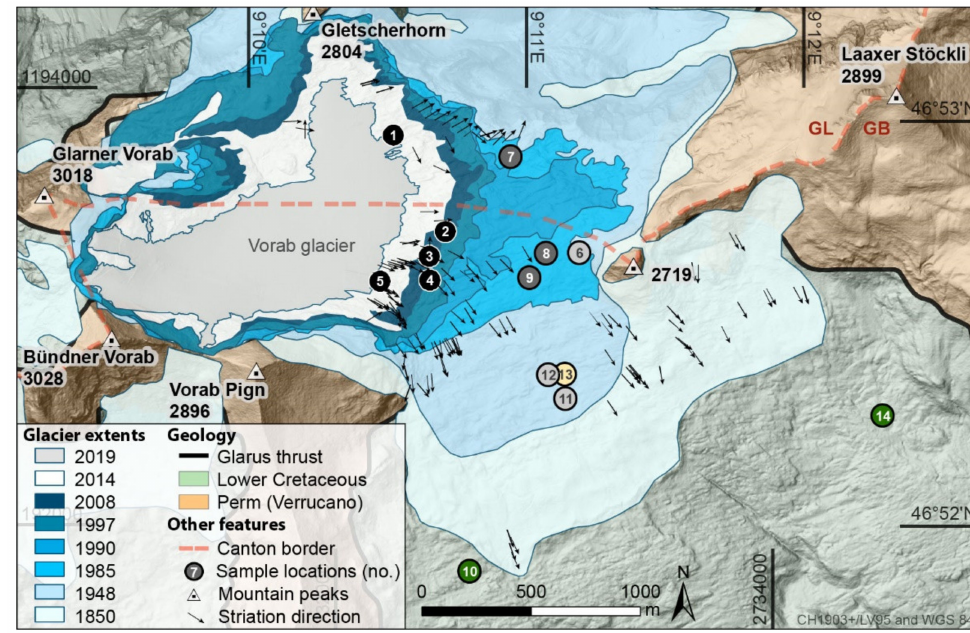
Figure 2. Geological map combined with the chronology of past glacier extents since the LIA. Circles show the location and number of the samples taken for 36 Cl analysis. Bedrock samples are grouped according to their position relative to the glacier extents: green: outside LIA extent (1850), light grey: inside 1948, dark grey: inside 1985, black: 2018; the only sampled boulder (Vorab-13) is yellow. Background map, geology and glacier extents are based on the swissAlti3D 2019, the geological 1:500,000 map and the topographic maps of the different years, reproduced with the authorization of the Swiss Federal Office of Topography (swisstopo). For location of the map see Figure